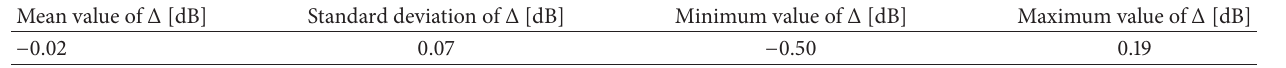
Table 4: Results of the Monte Carlo simulations for V ̸= 1 and 𝑙 = 1